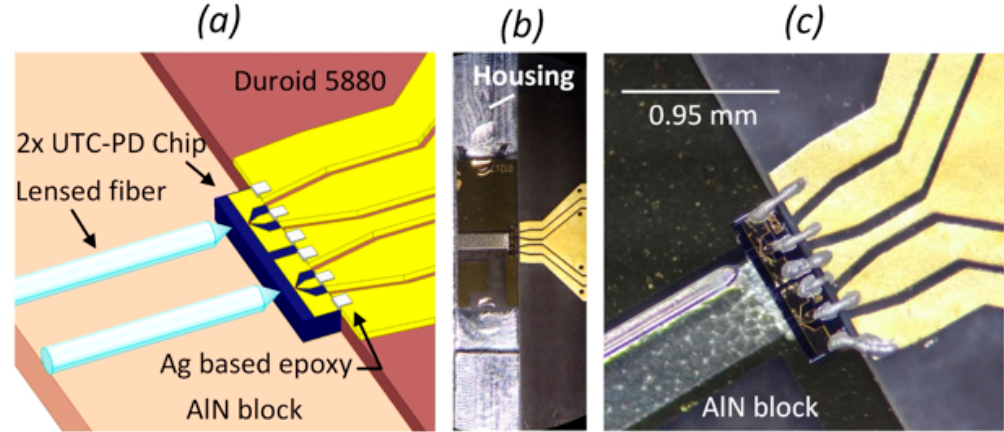
Figure 6. Images of the integration process: ( a ) designed transition, ( b ) AlN block and PCB aligned and glued to the housing, and ( c ) detail of thread bonding and fiber used to excite the UTC-PD.